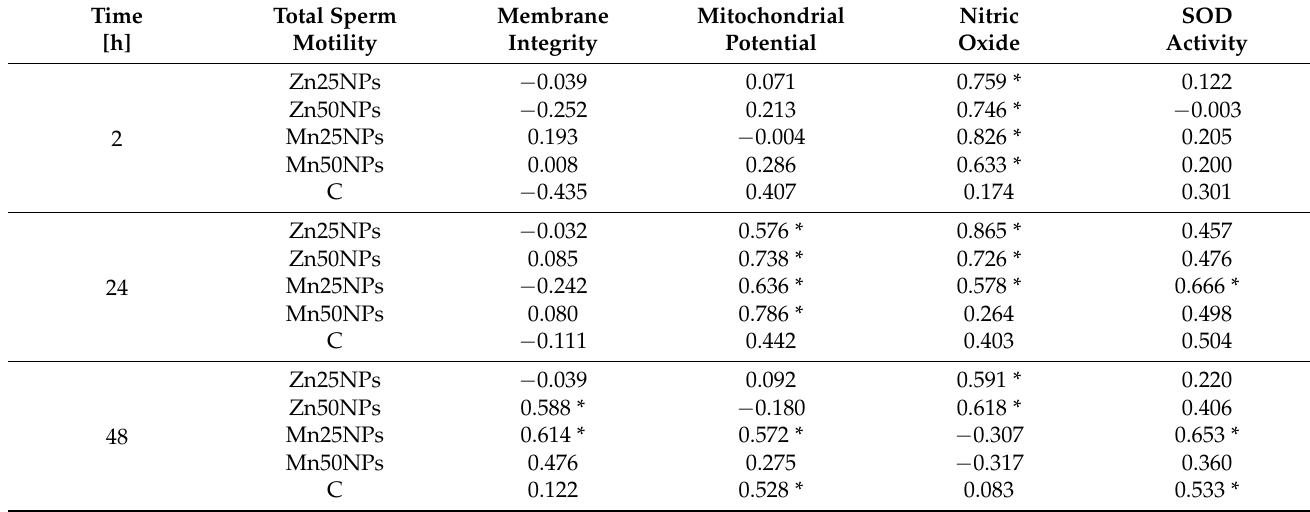
NO. Furthermore, a positive correlation between sperm motility and superoxide dismutase (SOD) activity was demonstrated in samples containing Mn25NPs (Table 2). Table 2. Correlations between total sperm motility and other sperm parameters during the preservation procedure. Time Total Sperm [h]